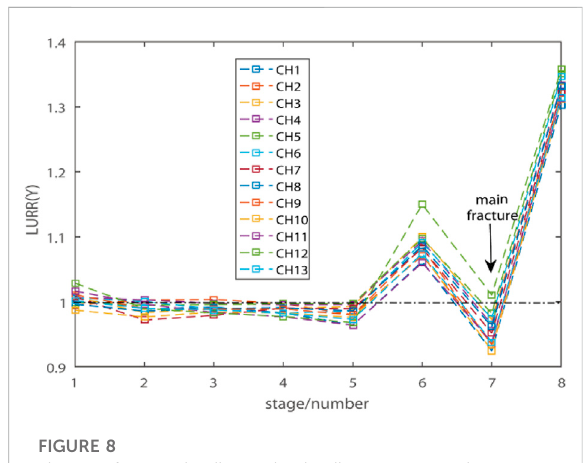
FIGURE 8 change of energy loading and unloading response